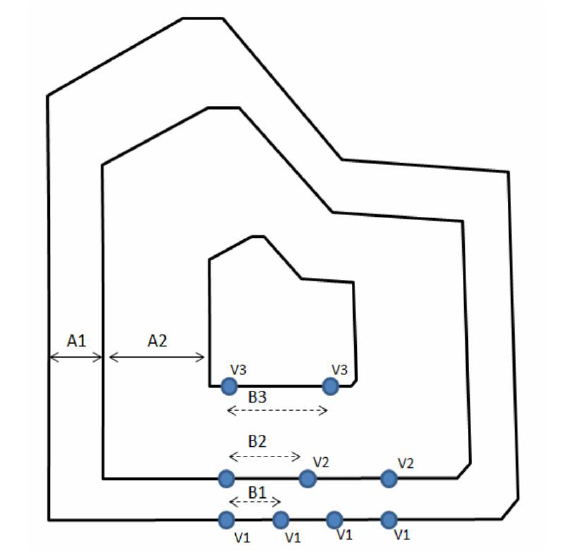
Figure 3: Construction of the punctual values of gardens, from the outline of the